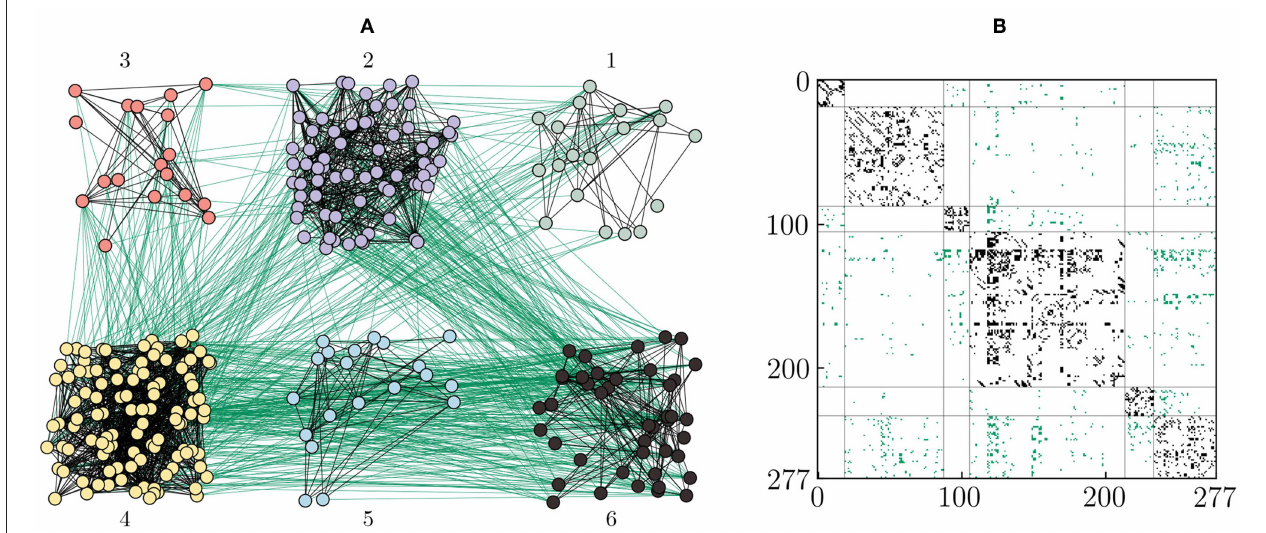
FIGURE 2 | Topology of the artificial C. elegans network. The network of 277 neurons is divided into 6 communities of different sizes using the Walktrap algorithm. (A) Neurons are colored according to their community [1: gray (19 neurons), 2: violet (69 neurons), 3: red (18 neurons), 4: yellow (108 neurons), 5: blue (20 neurons), 6: black (43 neurons)]. Electrical and chemical connections are shown as black and green lines, respectively. In this approach, electrical junctions exist only within every communities, whereas chemical synapses span only across communities. (B) The adjacency matrix with electrical (black) and chemical (green) edges, where the axes represent the node indices. The vertical and horizontal lines divides the matrix in the ordered communities (1 to 6), from left to right in the horizontal axis, and from up to down in the vertical axis,